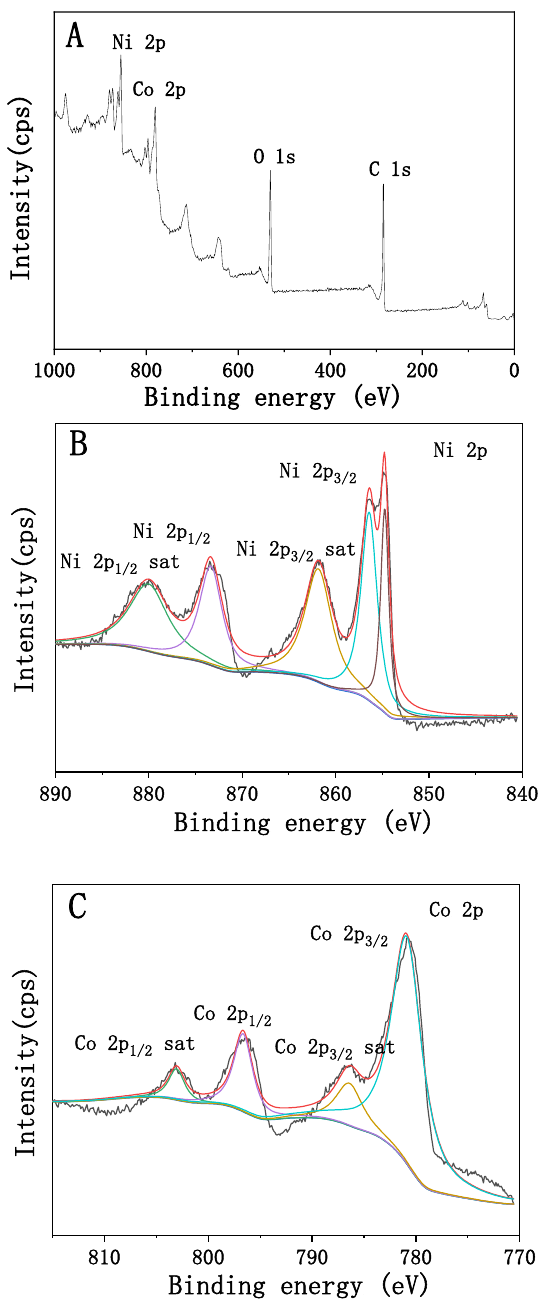
Figure 3. ( A ) XPS survey spectra of NiCo 2 O 4 /MWCNTs, ( B , C ) high-resolution spectra of Ni 2p and Co 2p.